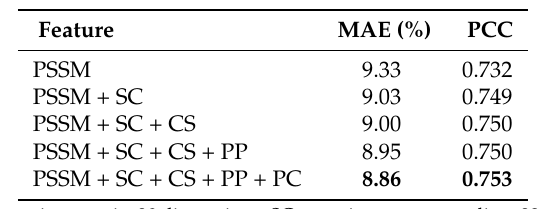
Different combinations of sequence-derived features for SDBRNN predictors on an independent test set (TS261).